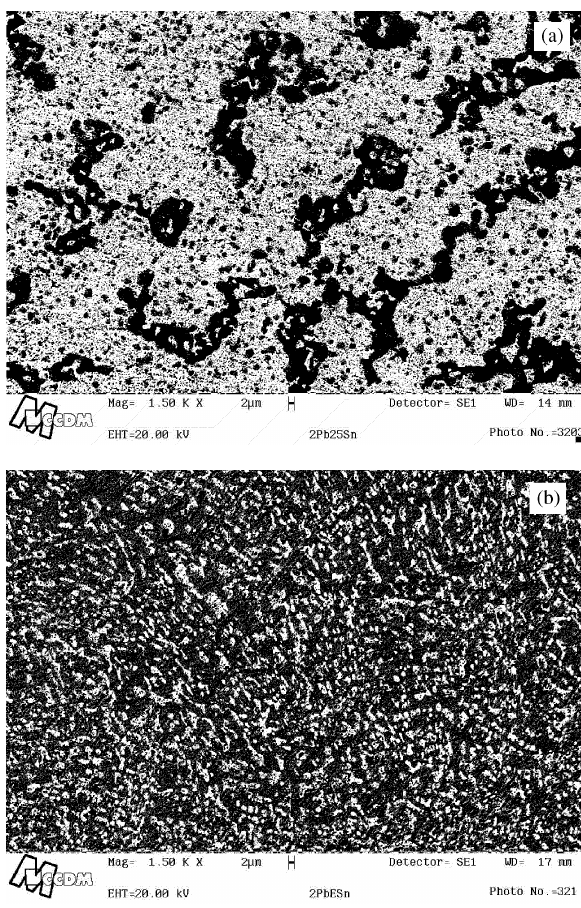
Figure 3. Microstructures of the eutectic alloy. (a) Sample A, ∆ T e = 6 K; (b) Sample B, ∆ T e = 23 K.